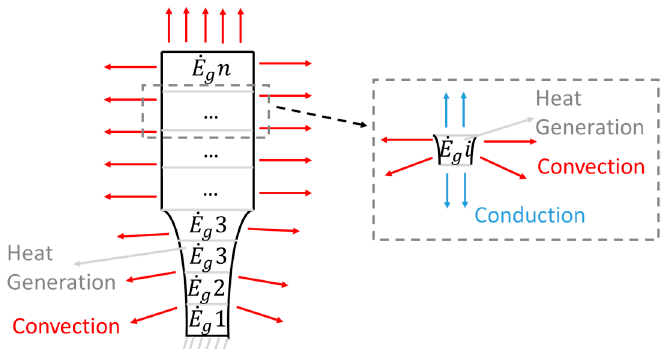
Figure 4. Heat transfer model for UHCF specimen.